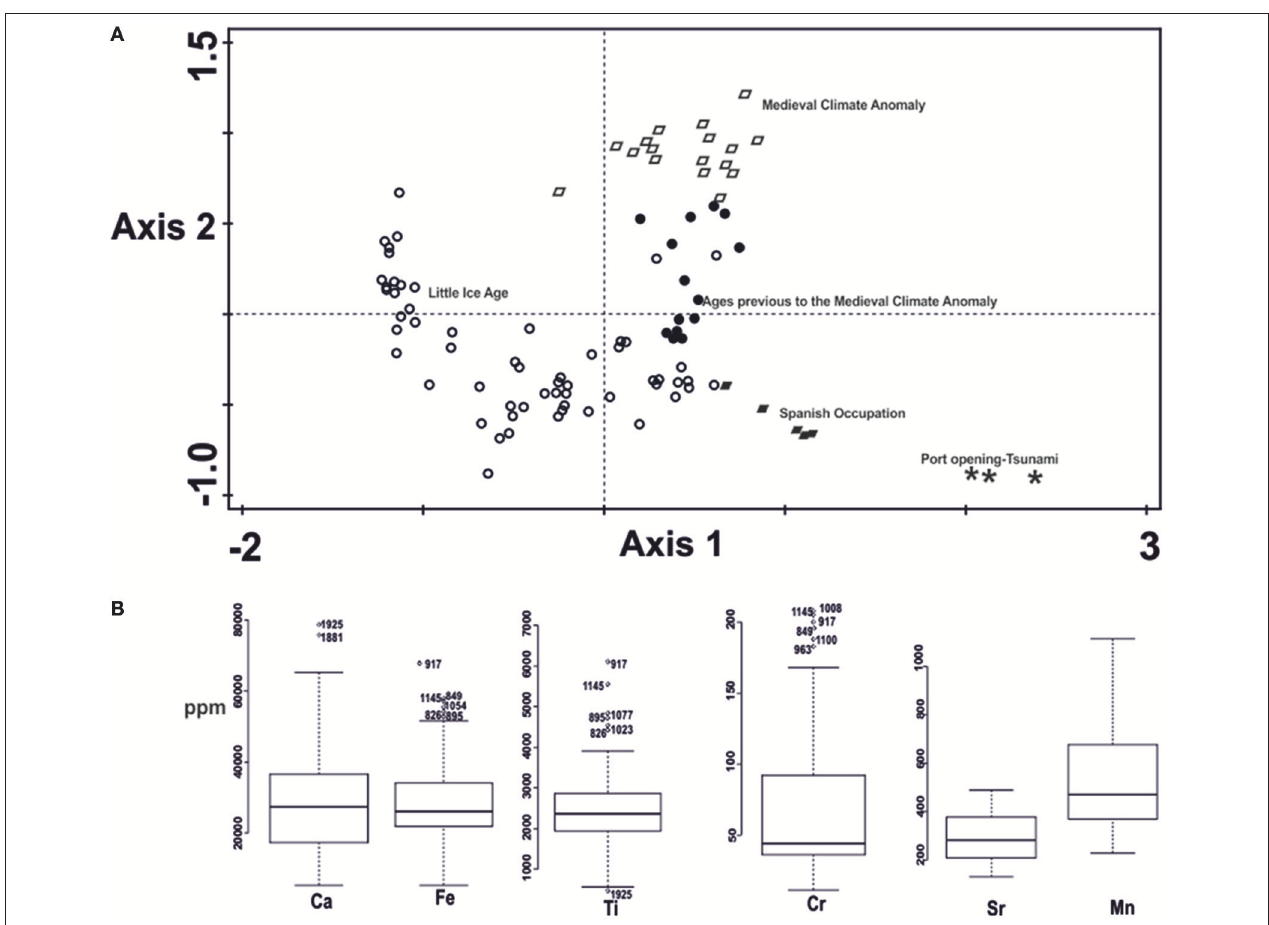
FIGURE 5 | (A) Non-metric multidimensional scaling ordination of chemical element composition by ages. The different symbols represent ordination scores. They represent ages in calibrated years AD. Ages in black open circles correspond with the Little Ice Age; in black circles to ages previous to the MCA; in open black rhomboids to the Medieval Climate Anomaly; in filled black rhomboids to the Spanish Occupation and in asterisks to the Manzanillo port opening and the tsunami of 1932. (B) Box and whiskers plots showing extreme values for the chemical elements.